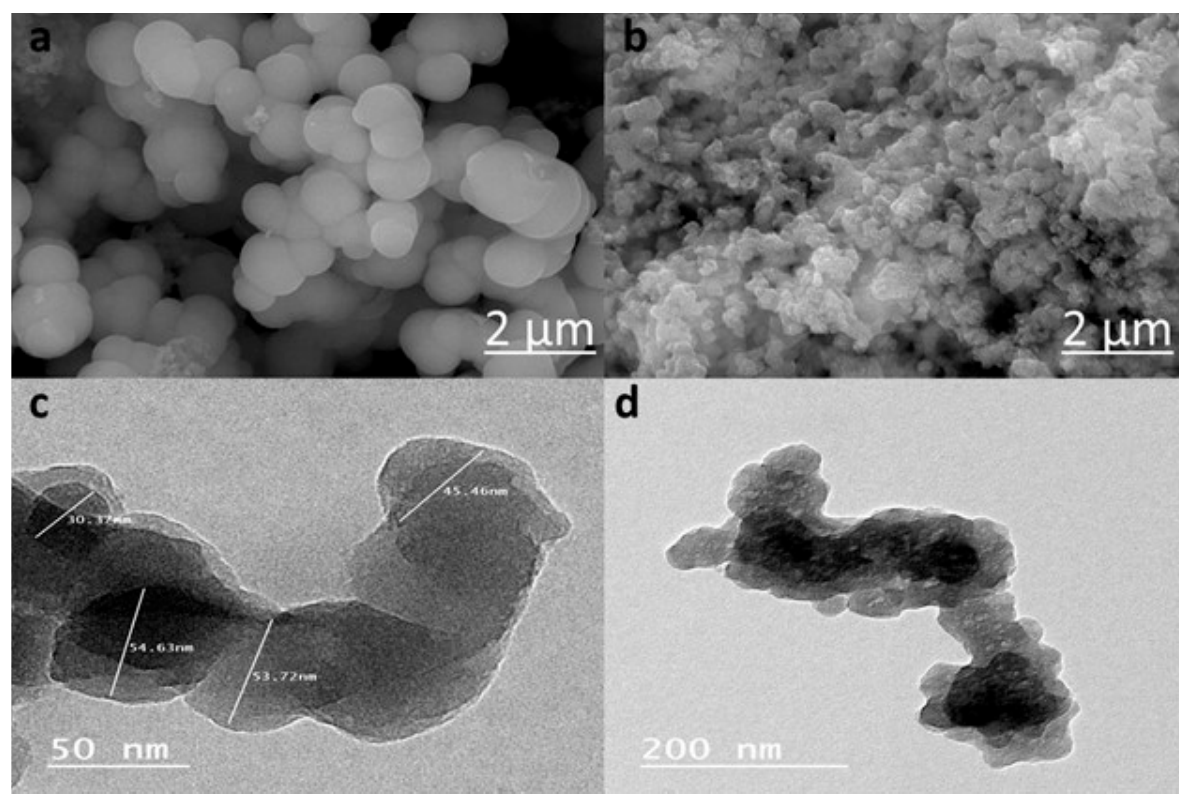
Figure 4. SEM images of the Chs NPs ( a ), M-Chs NC ( b ), and TEM images of Chs NPs ( c ) and M- Chs NC ( d ). M-Chs NC ( d